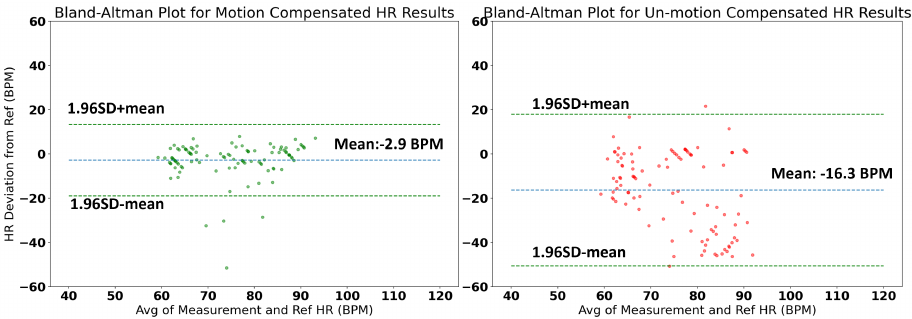
Figure 10. Bland–Altman plot of HR measurements when participants sit in a parked vehicle with motion compensation ( left ) and without motion compensation ( right